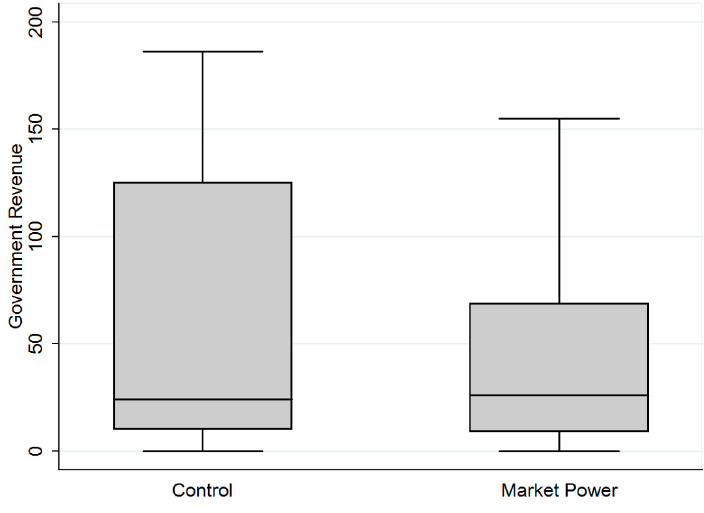
Figure 4. Box plot of government revenue by treatment.